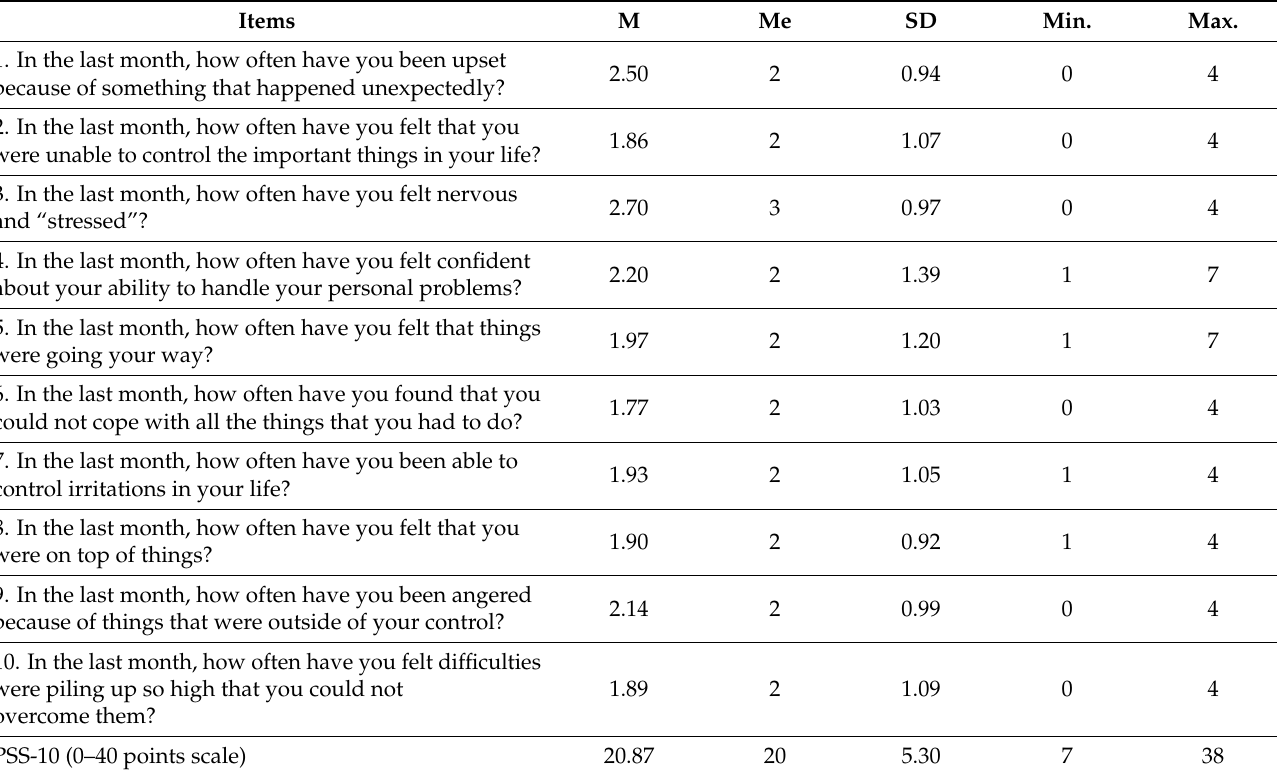
Table 1. The level of perceived stress Perceived Stress Scale-10 (PSS-10)—the results of individual items (0–4 points scale) and the overall result (0–40 points